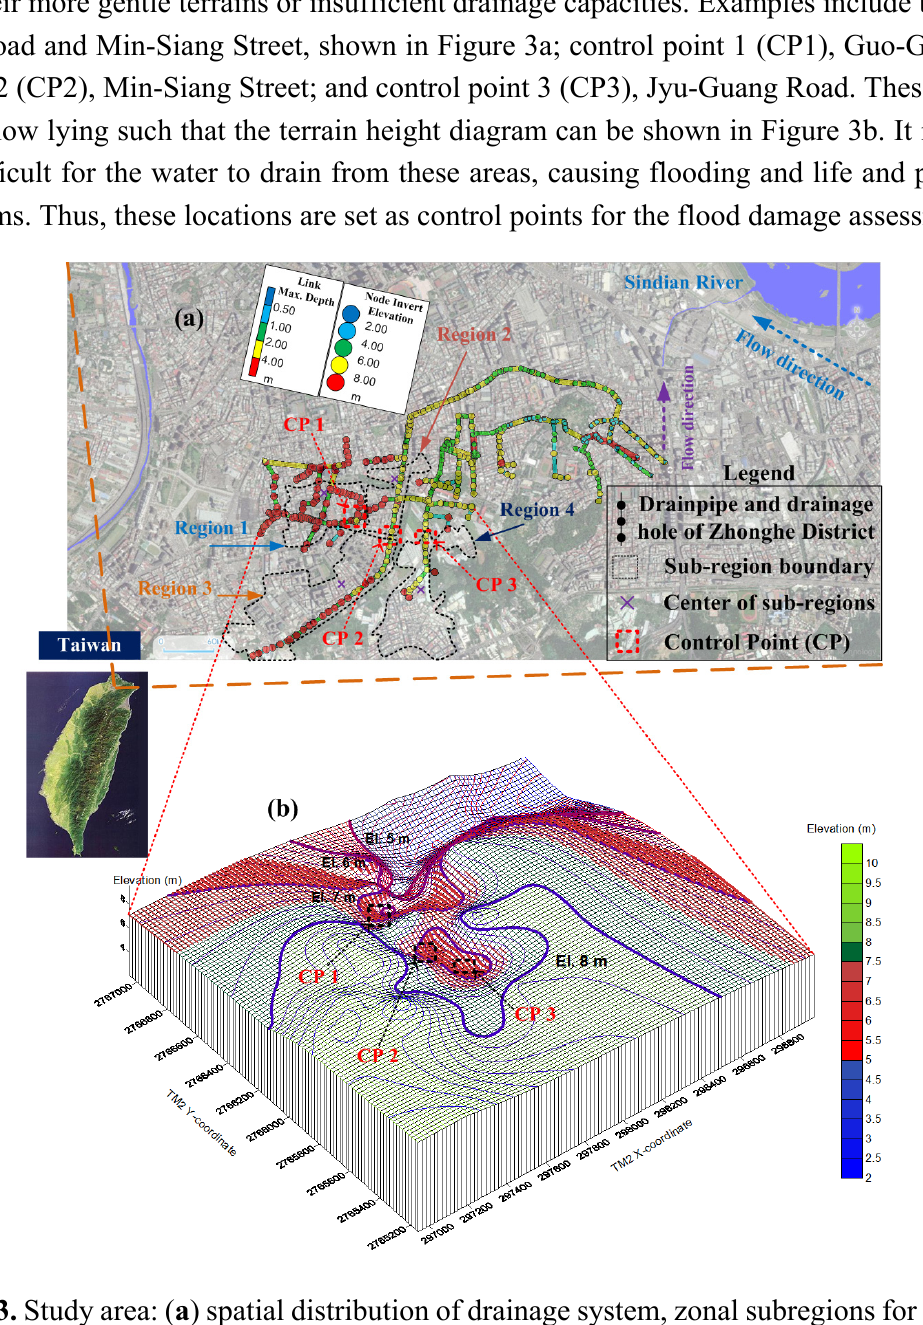
Figure 3. Study area: ( a ) spatial distribution of drainage system, zonal subregions for design of rainwater harvesting system using the fuzzy C-means cluster algorithm and the low-lying control points; ( b ) terrain height above sea